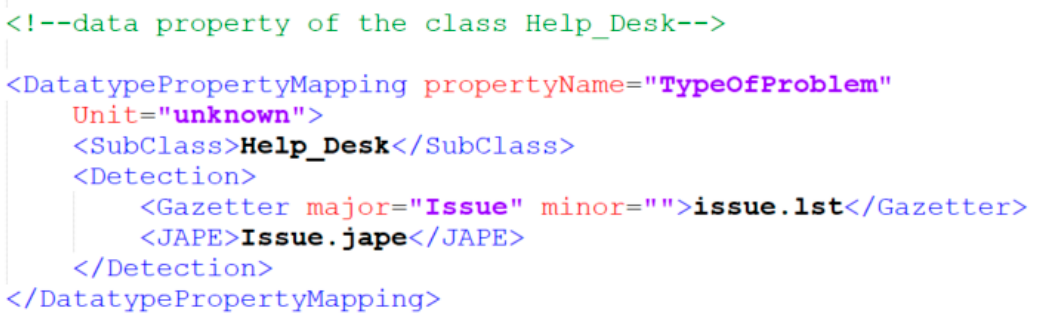
Figure 11. Example mapping for the information needs ‘typeOfProblem’.